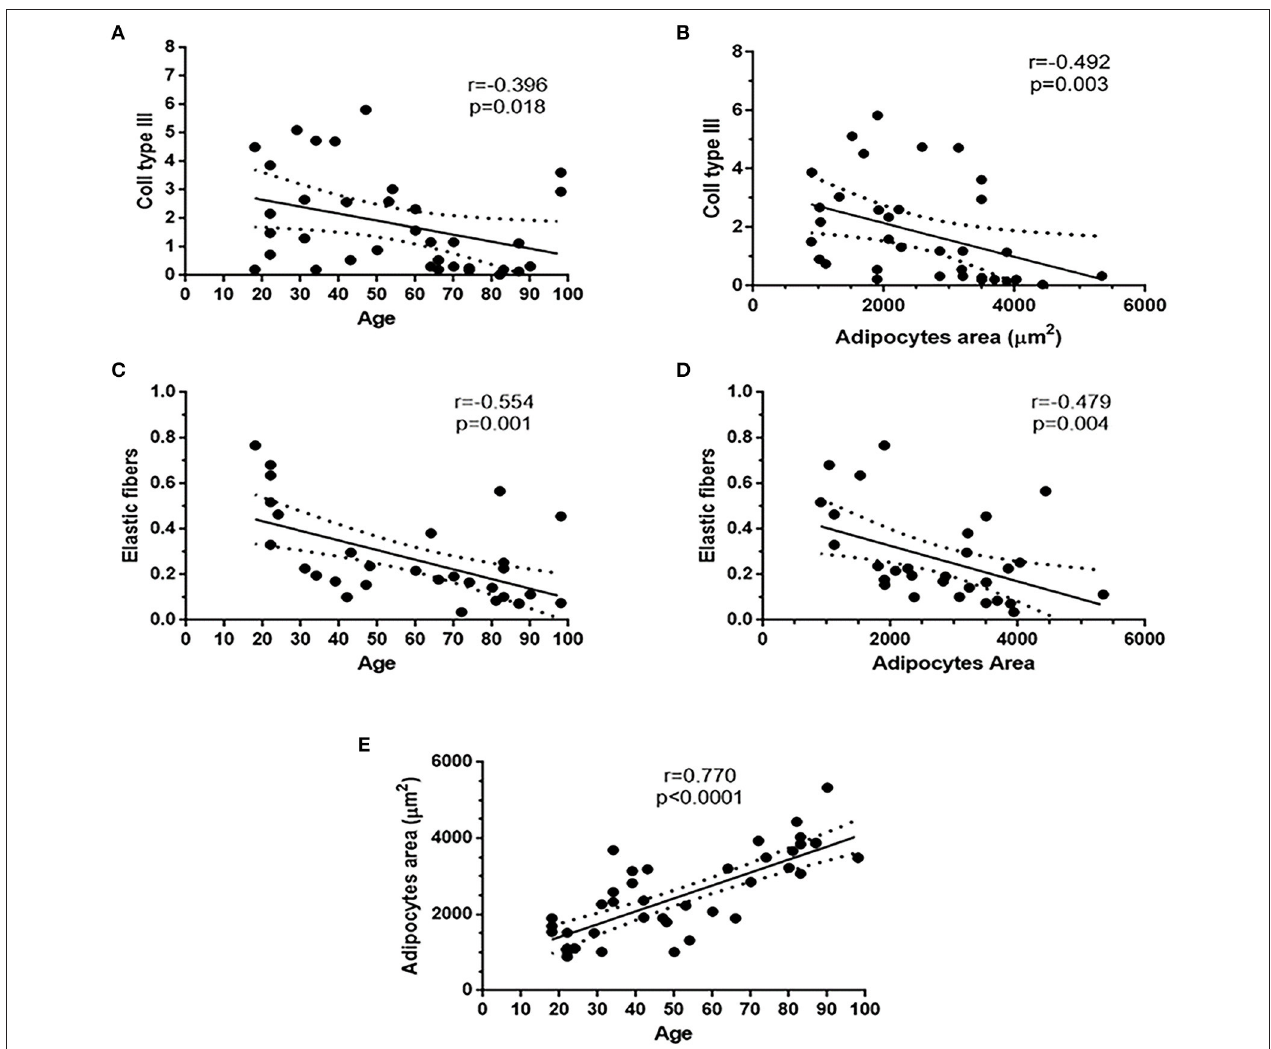
FIGURE 6 | Existing correlations in the overall patient’s cohort. Collagen III and elastic fibers content were negatively correlated with age (A,C) and adipocytes area (B,D) . Adipocytes area was positively correlated with age (E)